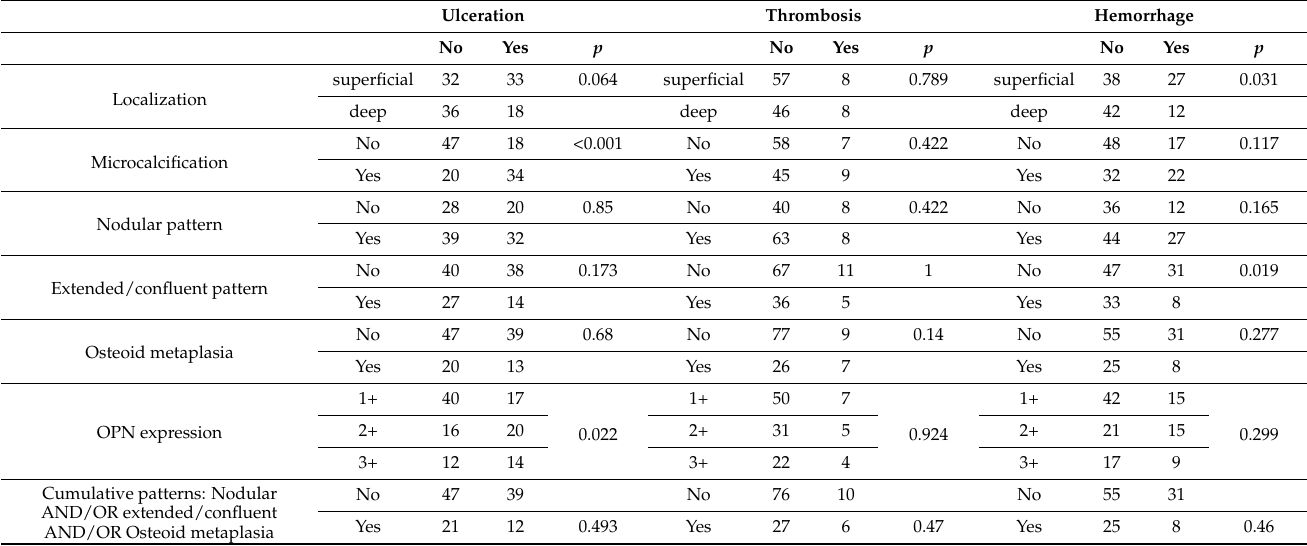
Table 2. Occurence of ulceration, thrombosis and hemorrhage in subgroups with various calcifica- tion